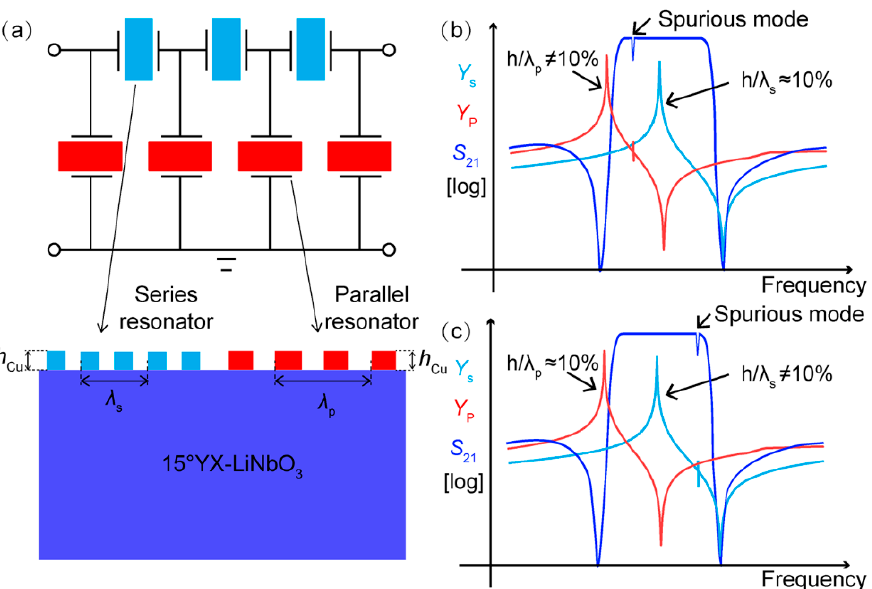
Figure 3. ( a ) The basic structure of a conventional ladder-type SAW filter. ( b , c ) Schematic diagram of the existence of spurious modes in the conventional filter .